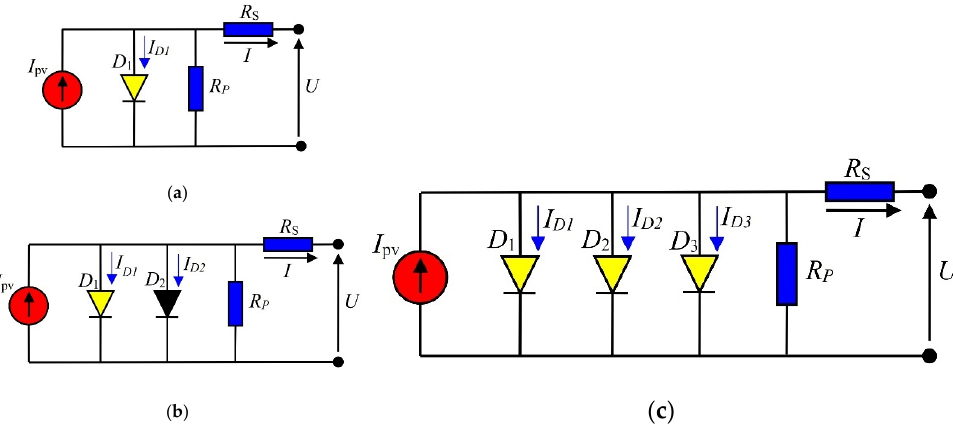
Figure 1. Photovoltaic (PV) equivalent circuits models: ( a ) single-diode model (SDM), ( b ) double- diode model (DDM) and ( c ) triple-diode model (TDM).